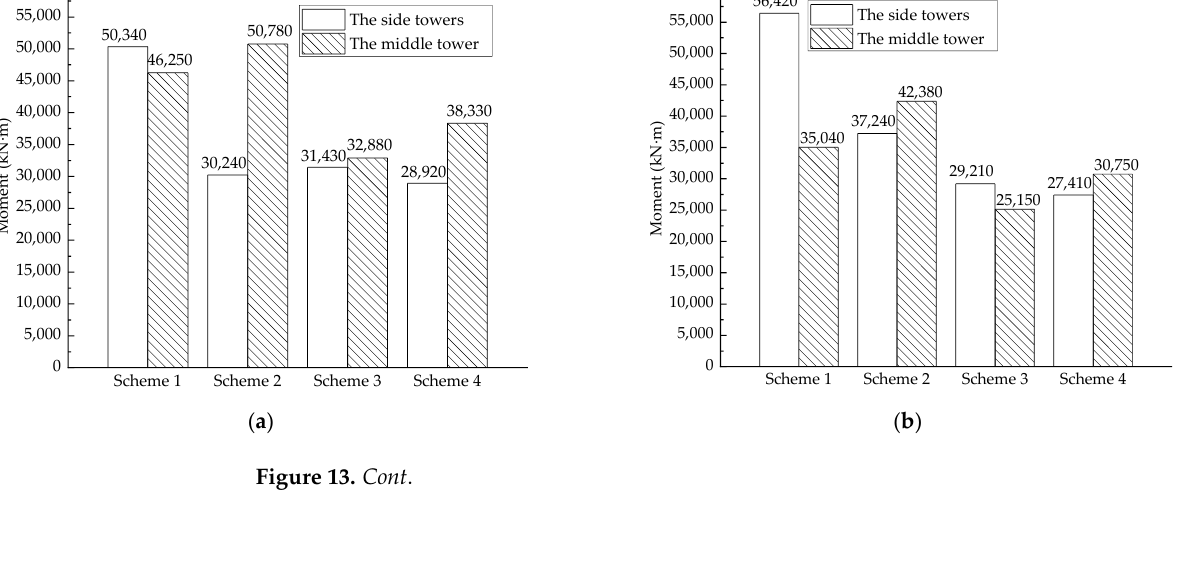
( d ) ( e ) Figure 13. Comparison of the longitudinal tower shaft moment with different layout schemes of the viscous dampers. ( a ) San Fernando Pacoima Dam record; ( b ) Whittier Narrows-01 record; ( c ) Taft Lincoln School record; ( d ) El Centro Site record; ( e ) MtCarmel-2008-0418a record.